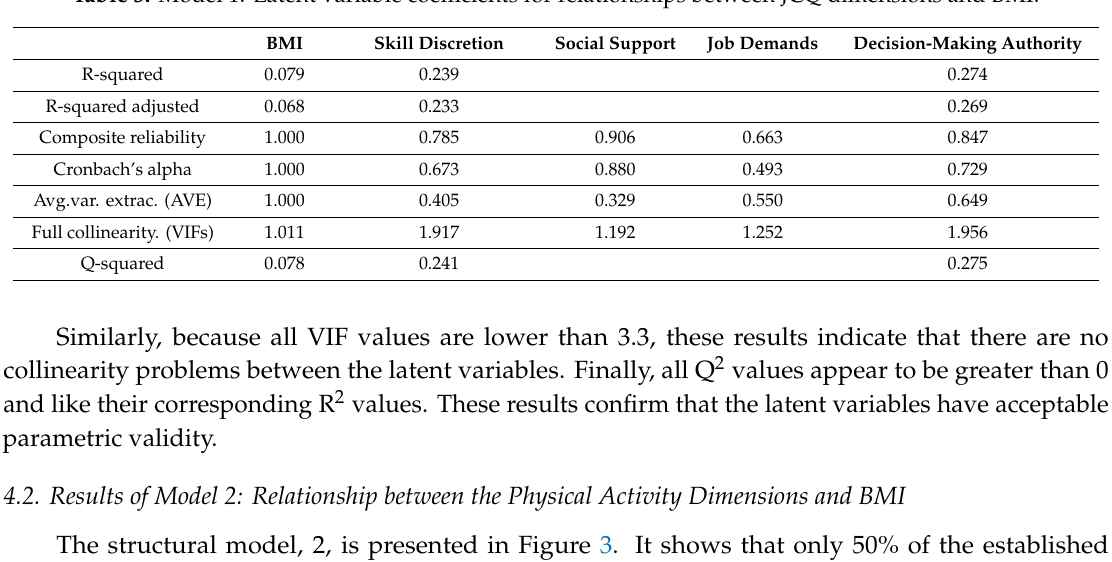
Table 3. Model 1. Latent variable coe ffi cients for relationships between JCQ dimensions and BMI.